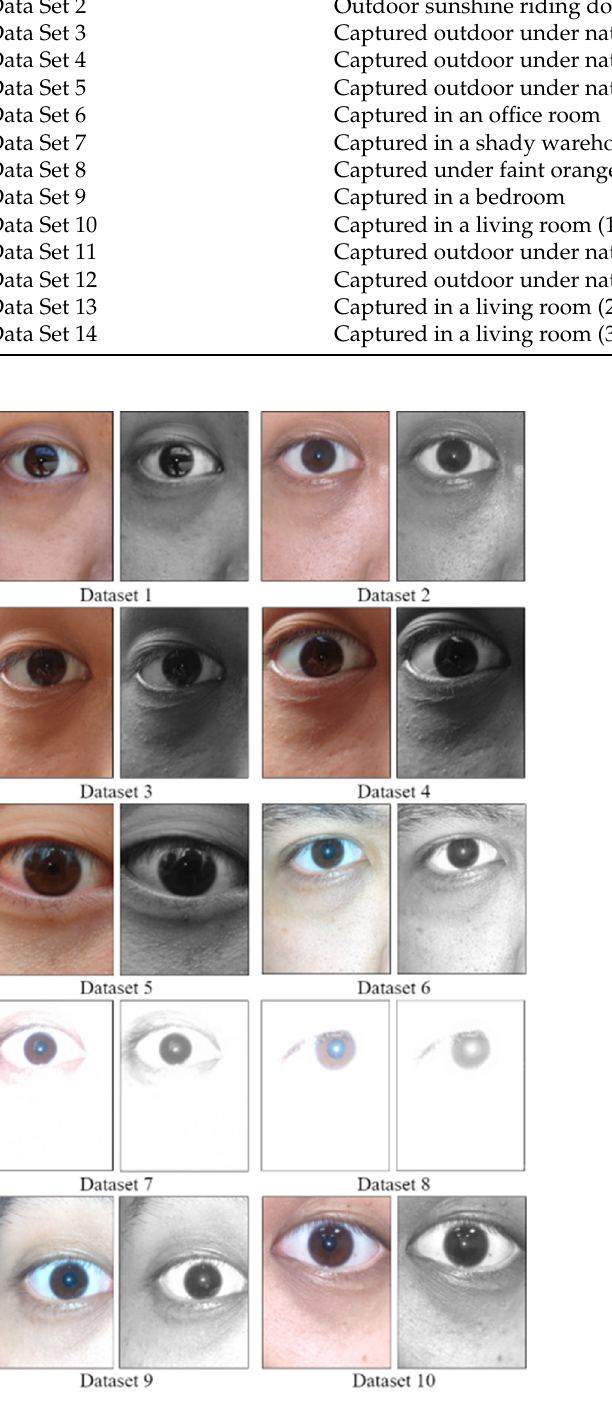
Figure 48. Results obtained after grayscaling for each data set. After grayscale images were obtained for each data set, Canny edge detection was executed on these images by using the Canny function in Python OpenCV. The literature does not mention suitable threshold values for Canny edge detection; therefore, we